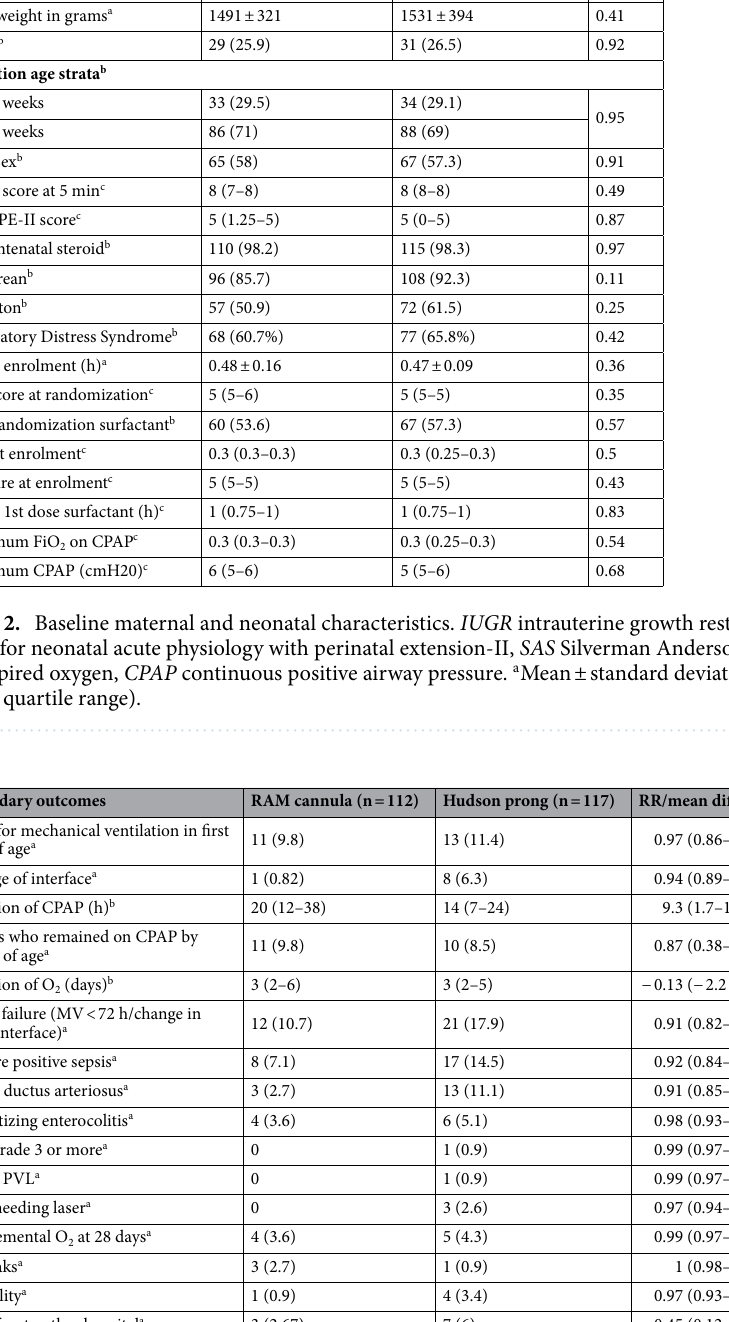
Table 3. Secondary outcomes and neonatal morbidities. MV mechanical ventilation, IQR interquartile range, CPAP continuous positive airway pressure. a n (%). b Median (inter quartile range). c Mean (standard deviation).